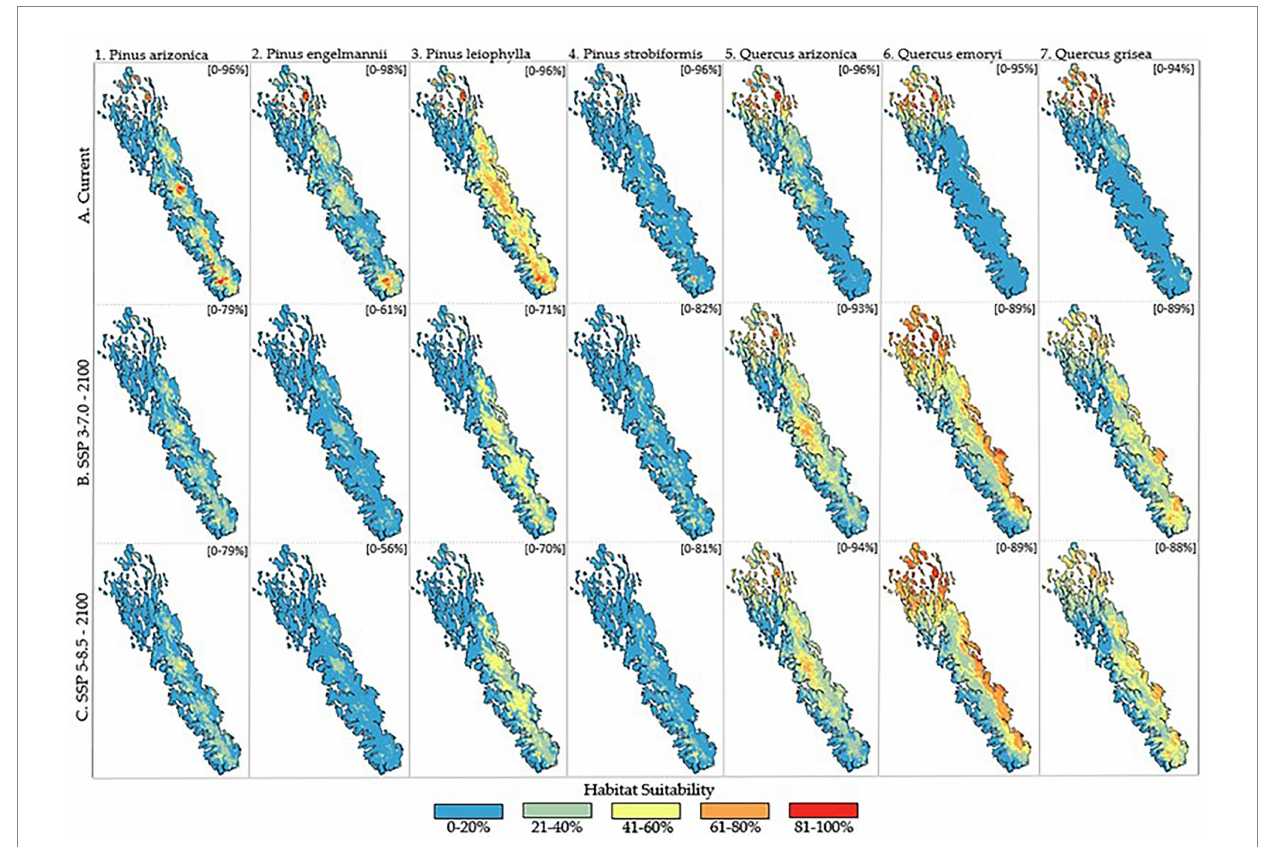
FIGURE 4 Habitat suitability for the seven tree species of interest across the Sierra Madre Occidental for current climatic conditions, end-of-century (2100) climatic conditions for SSP 3–7.0, and end-of-century (2100) climatic conditions for SSP 5–8.5. Habitat suitability probability is represented on a gradient of blue (low suitability) to red (high suitability). Predicted model probability range is in the upper right corner of each species map as [lower- upper%]. Figure column is assigned numerically while column is assigned alphabetically for rapid lookup (i.e., Pinus Strobiformis at end-of-century conditions for SSP 3–7.0 =